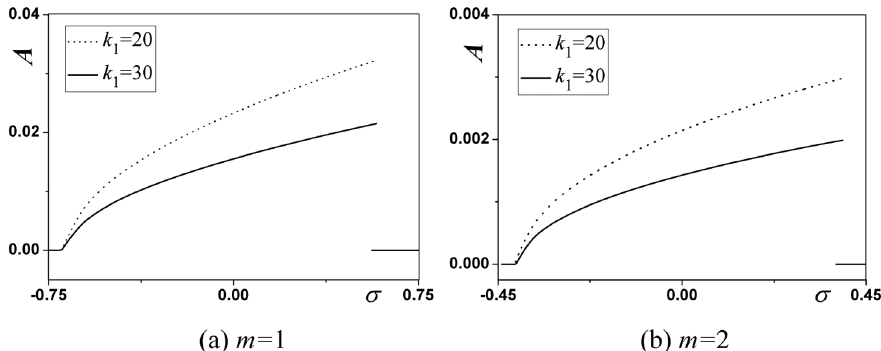
Fig. 12. Effects of the non-linear coef fi cient k 1 .